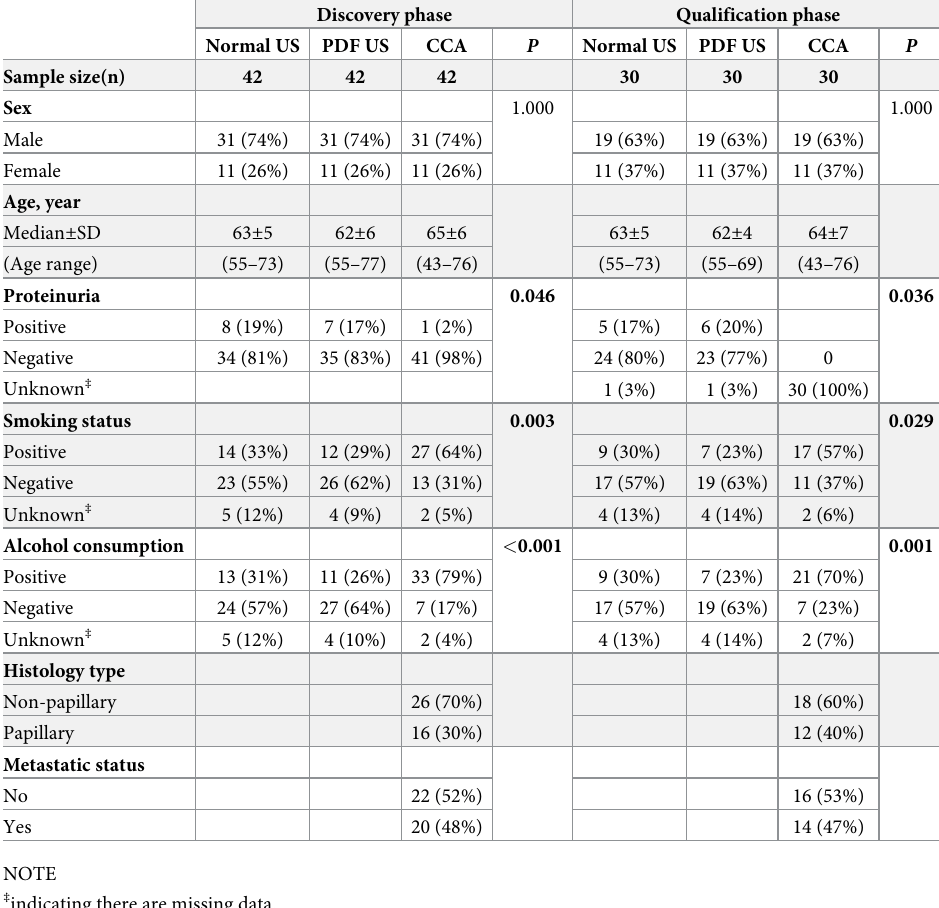
Table 1. The clinical and demographic information on all subjects for the discovery and qualification